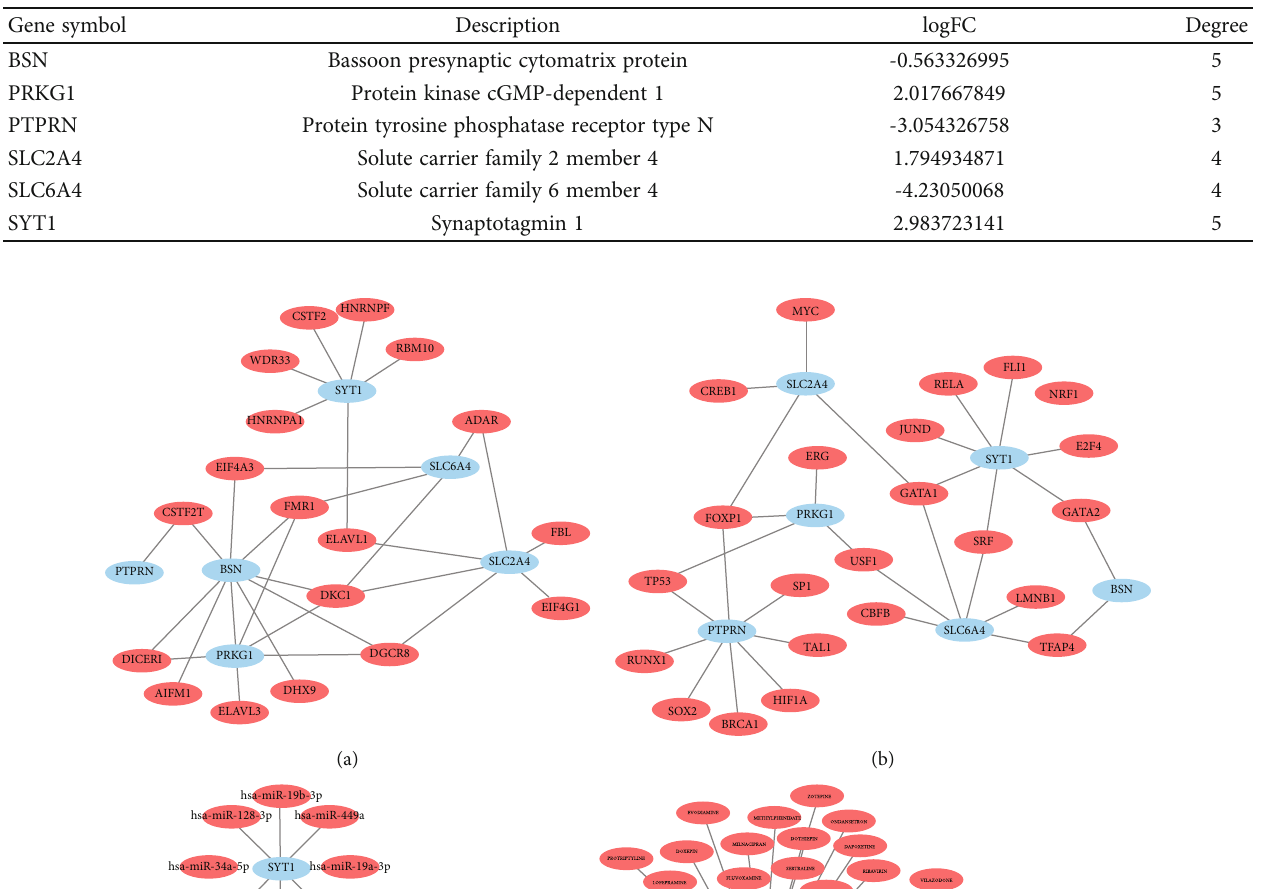
Table 2: The list of hub genes.